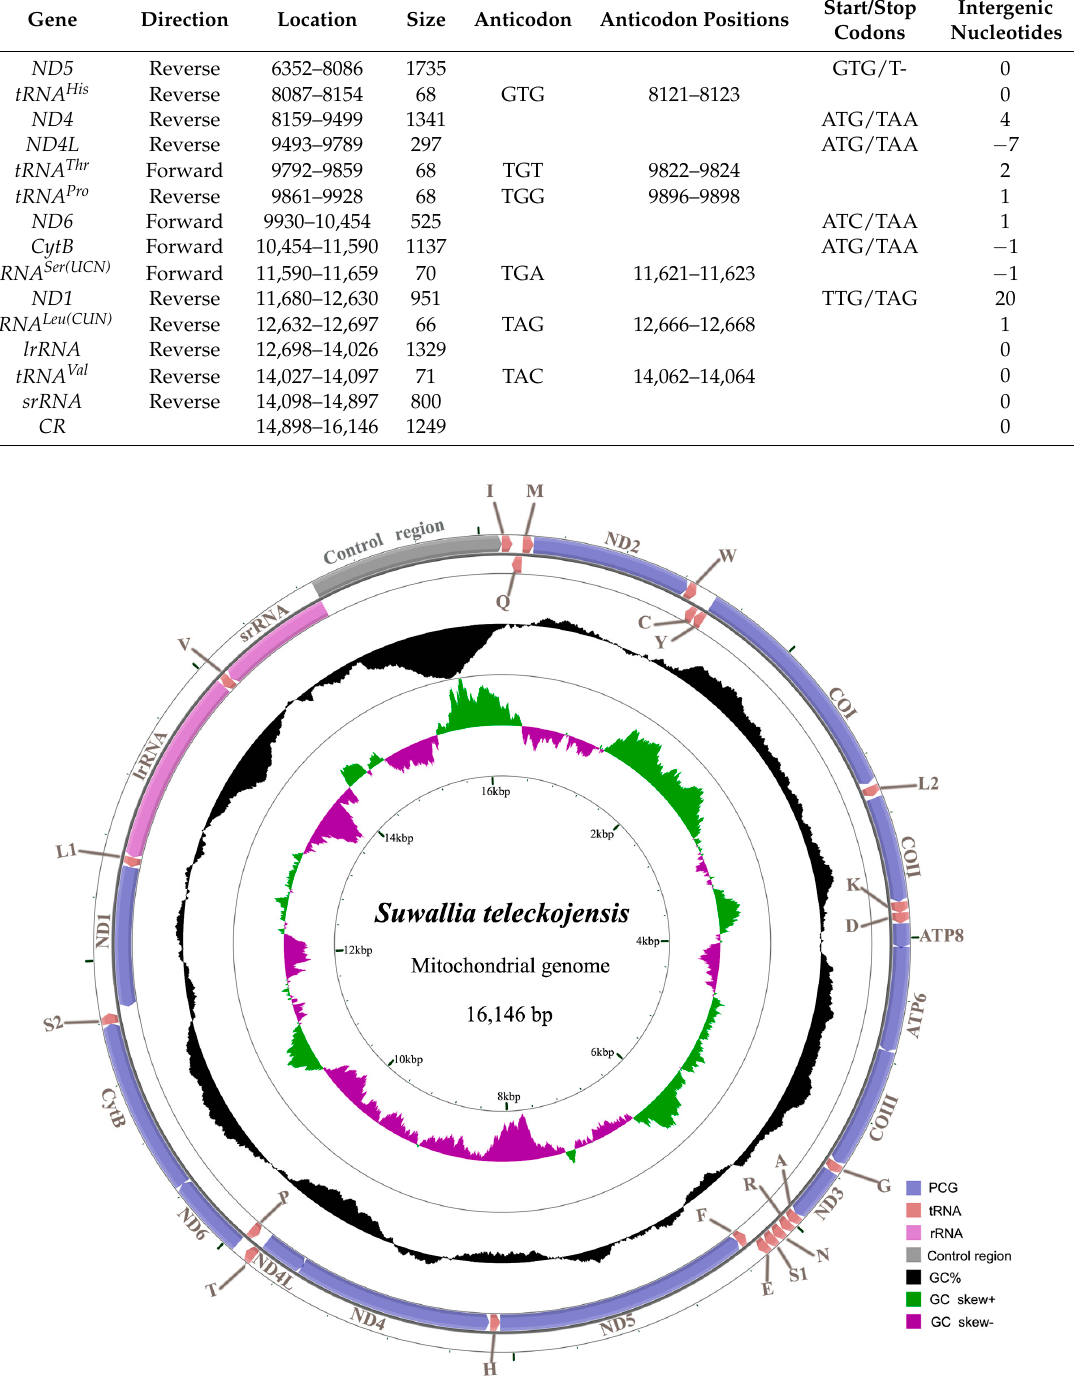
Figure 1. Map of the mitochondrial genome of S. teleckojensis . Direction of gene transcription is indicated by the arrows. Protein-coding genes (PCGs) are shown as blue arrows, rRNA genes as purple arrows, tRNA genes as red arrows, and control region (CR) as gray arrows. tRNA genes are labeled according to single-letter IUPAC-IUB abbreviations (L1: UUR, L2: CUN, S1: AGN, S2: UCN). The GC content is plotted using a black sliding window, as the deviation from the average GC content of the entire sequence. GC skew is plotted as the deviation from the average GC skew of the entire sequence.